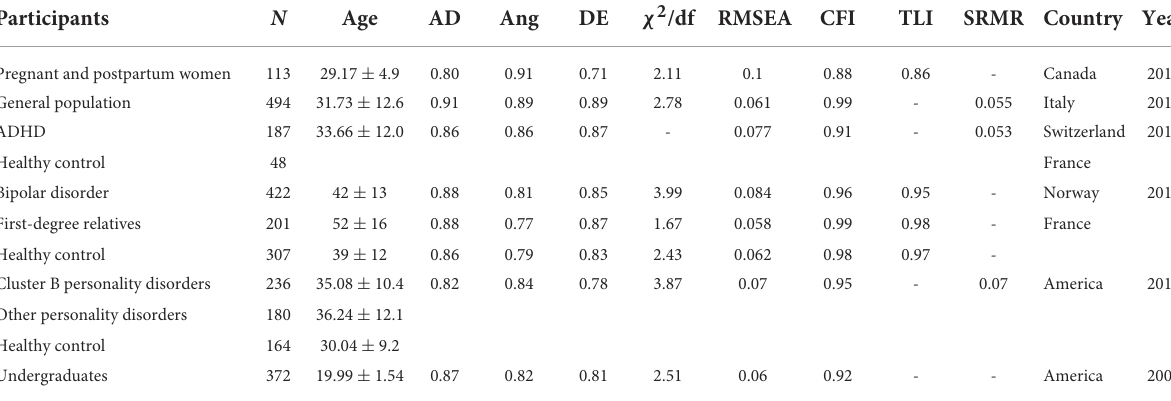
TABLE 1 Psychometric property studies of the ALS-SF.